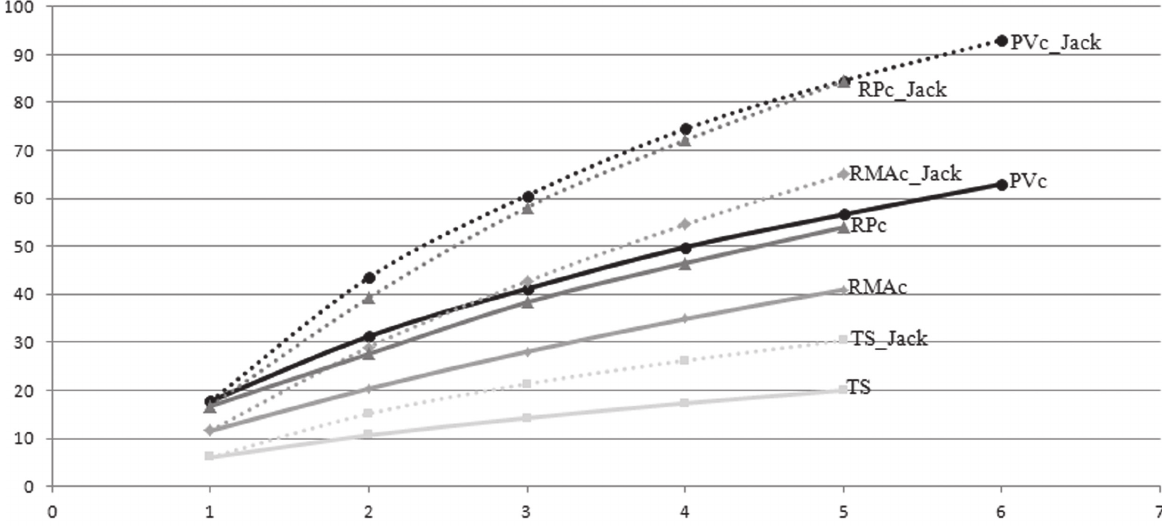
Figure 3 - Sampling rarefaction curves from caves with five or more collections and Jackknife first order estimator. PVc - Parede Vermelha cave; RPc - Rio dos Pombos cave; RMAc - Ressurgência do Morro de Alvo cave; TS - Torras System. For each cave, solid lines are Mao Tau sampling rarefaction curves and dashed lines are Jackknife first order richness estimator. Horizontal numbers means samples and vertical numbers means